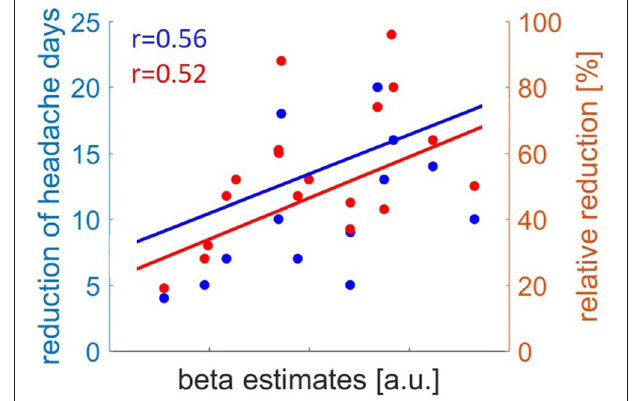
FIGURE 2 | Correlation of gray matter volume in Medial Orbital Gyrus before drug withdrawal and clinical outcome of headache reduction. Absolute reduction of headache days in blue and relative reduction of headache days in